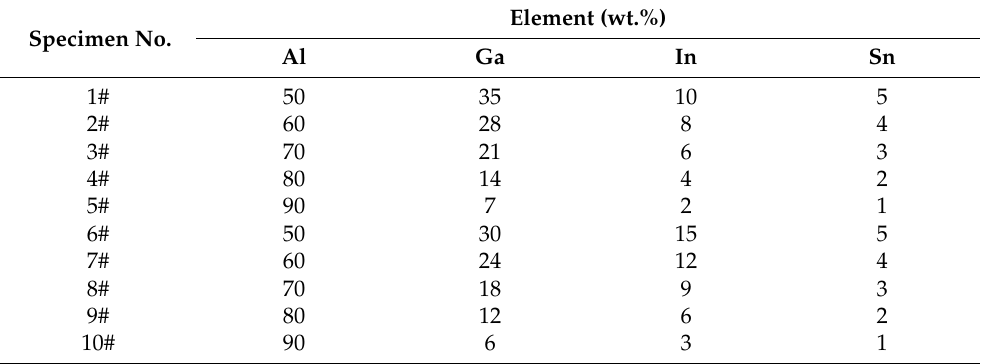
Table 2. Alloy compositions used for experiments. Specimen